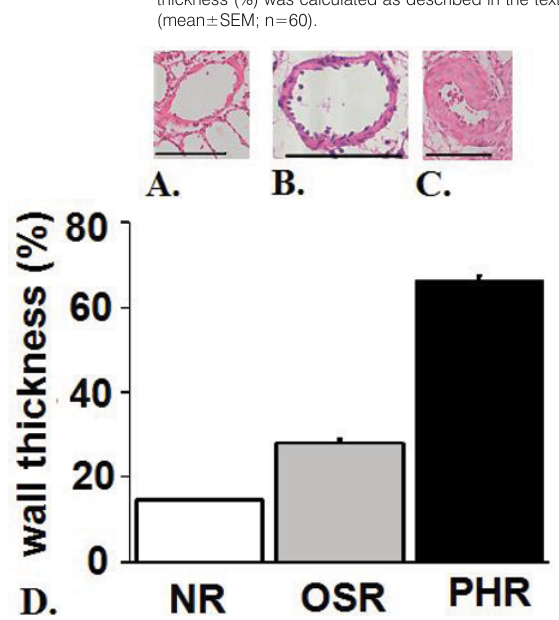
Figure 1. Muscularized pulmonary arteries (with an external diameter less than 150 μm) from (A) NR (B) OSR and (C) PHR. Scale bars represent 100 μM. (D): The wall thickness (%) was calculated as described in the text (mean±SEM; n=60).